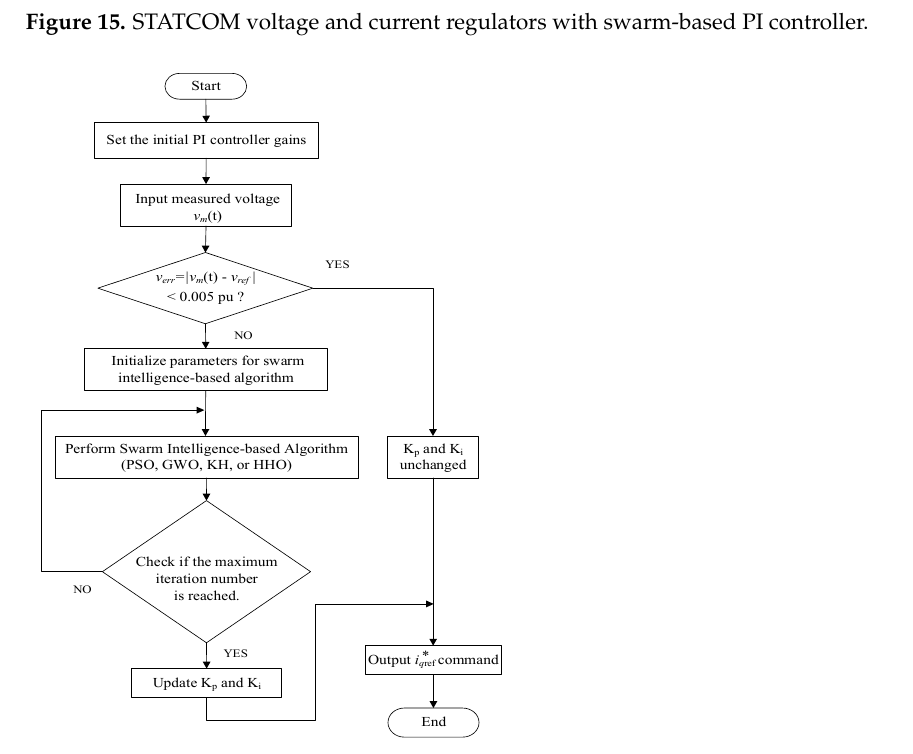
Figure 16. Flowchart of the proposed swarm intelligence-based algorithms for optimizing PI con- troller gains.